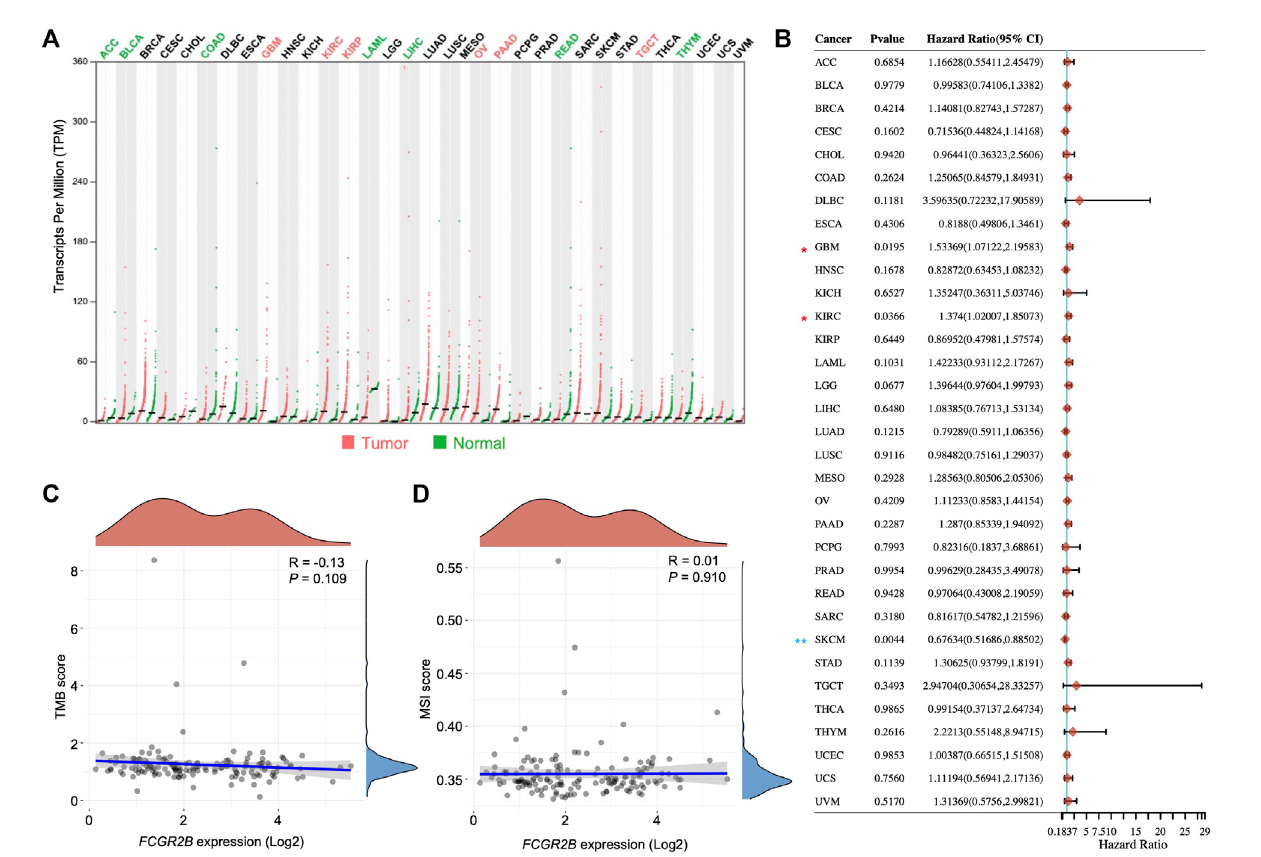
FIGURE 4 Fc γ RIIb expression is strongly associated with GBM. (A) Dot plots showing the mRNA expression of FCGR2B in different tumor types and normal tissues from the TCGA cohort. Red label, signi fi cantly higher in tumor; green label, signi fi cantly higher in normal; black label, not signi fi cant. ACC, adrenocortical carcinoma; BLCA, bladder urothelial carcinoma; BRCA, breast invasive carcinoma; CESC, cervical squamous cell carcinoma and endocervical adenocarcinoma; CHOL, cholangiocarcinoma; COAD, colon adenocarcinoma; DLBC, lymphoid neoplasm diffuse large B-cell lymphoma; ESCA, esophageal carcinoma; HNSC, head and neck squamous cell carcinoma; KICH, kidney chromophobe; KIRC, kidney renal clear cell carcinoma; KIRP, kidney renal papillary cell carcinoma; LAML, acute myeloid leukemia; LIHC, liver hepatocellular carcinoma; LUAD, lung adenocarcinoma; LUSC, lung squamous cell carcinoma; MESO, mesothelioma; OV, ovarian serous cystadenocarcinoma; PAAD, pancreatic adenocarcinoma; PCPG, pheochromocytoma and paraganglioma; PRAD, prostate adenocarcinoma; READ, rectum adenocarcinoma; SARC, sarcoma; SKCM, skin cutaneous melanoma; STAD, stomach adenocarcinoma; TGCT, testicular germ cell tumors; THCA, thyroid carcinoma; THYM, thymoma; UCEC, uterine corpus endometrial carcinoma. (B) Forest plotsshowingtheHRof FCGR2B indifferenttumortypesfromtheTCGAcohortthroughunivariateCoxregressionanalysis.Horizontallinesrepresentthe95% CIofHR.Redasterisk,HR > 1and p < 0.05;blueasterisk,HR < 1and p < 0.05.* p < 0.05,** p < 0.01. (C , D) DotplotsdepictingthecorrelationbetweenthemRNA expression of FCGR2B and tumor mutational burden (TMB) and microsatellite instability